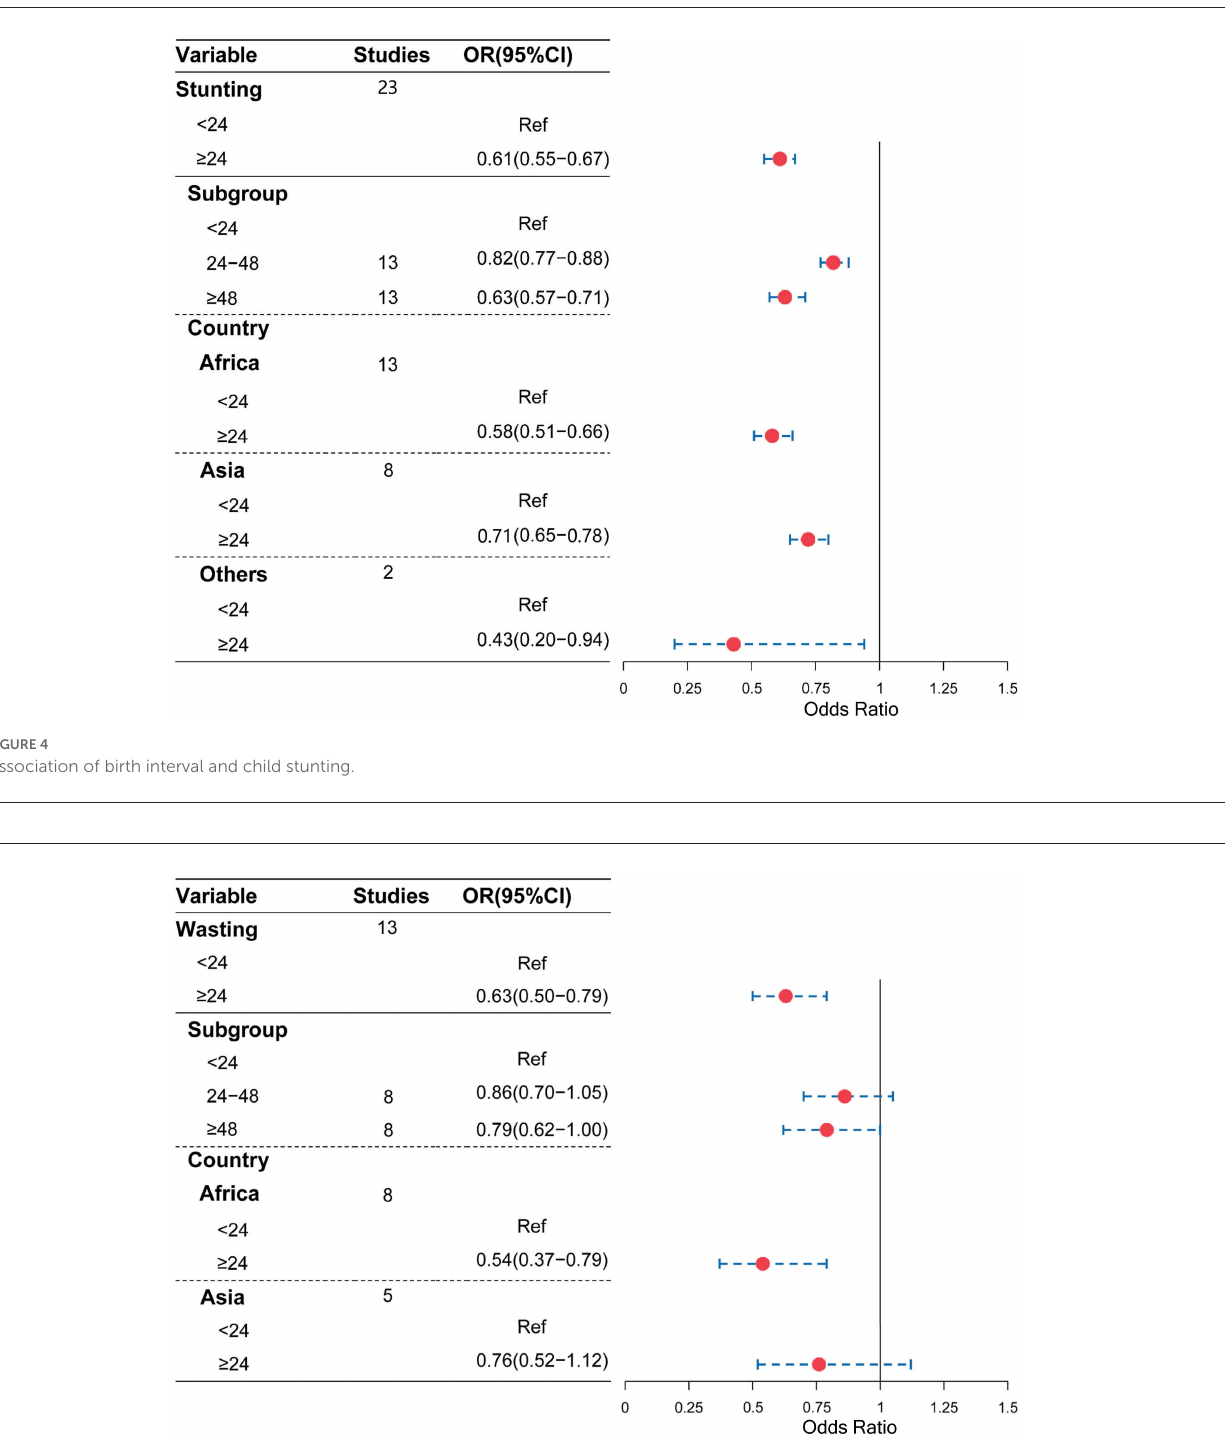
FIGURE5 Association of birth interval and child wasting.